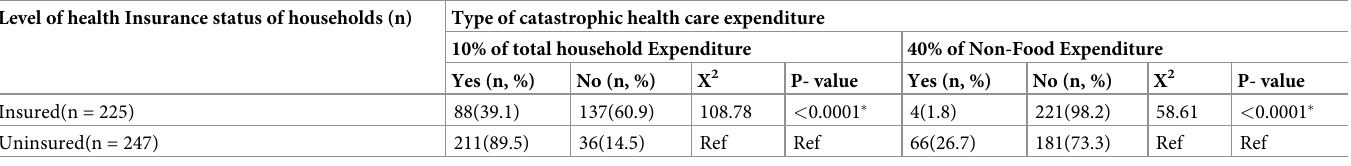
measures. In the meantime, the average CBHI impact on catastrophic health care expenditure Table 3. Catastrophic health care expenditure measured as a percentage of total household expenditure and non-food expenditure at 10% and 40% thresholds among insured and uninsured households in Kutaber district, Ethiopia, 2020(n = 472). Level of health Insurance status of households (n) Type of catastrophic health care